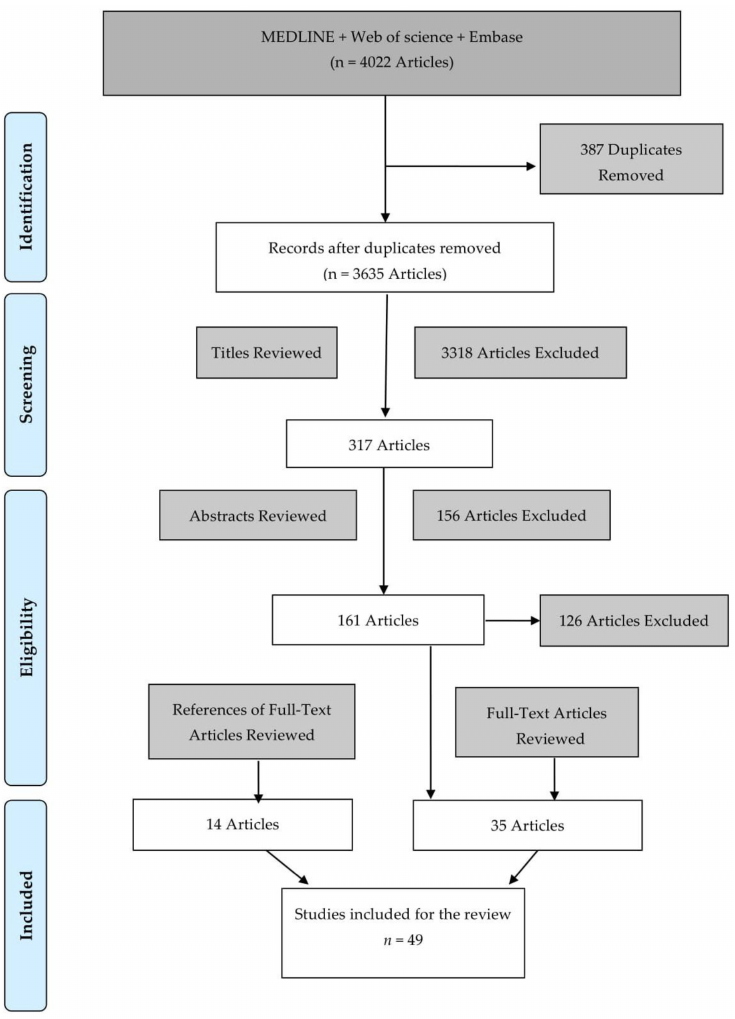
Figure 1. PRISMA Flow diagram of the search strategy and study